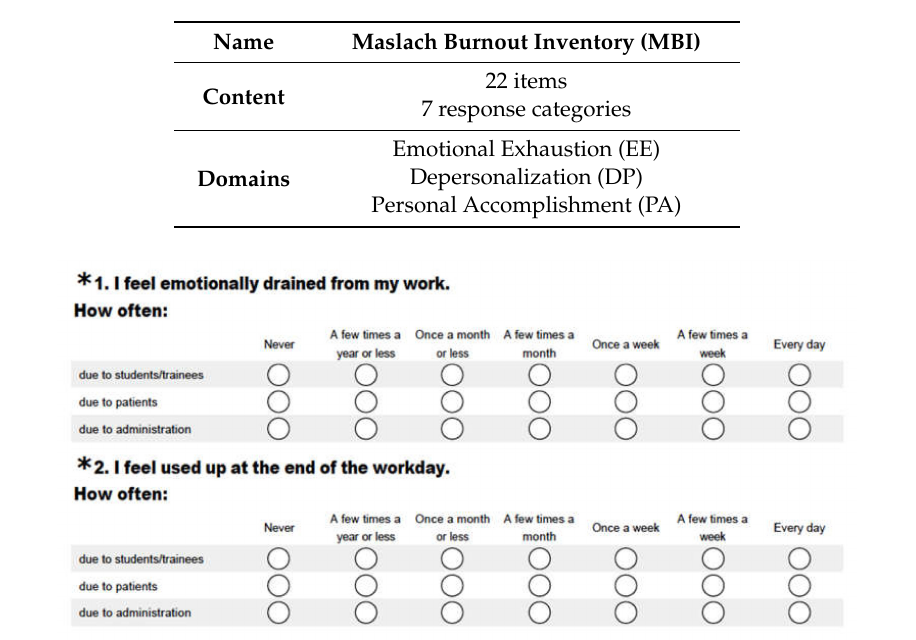
Table 2. Maslach Burnout Inventory (MBI): Major Instrument Used in Measuring Burnout among Healthcare Workers.